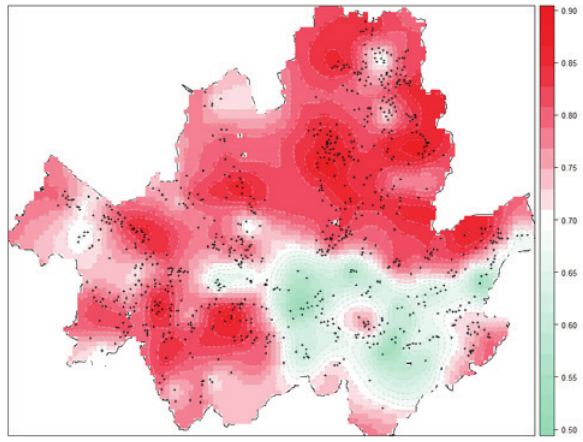
Figure 5. Spatial correlation of the rent-to-price ratio The symbol “+” indicates the location of the apartment complex, and the ratio is the average value between January and December of 2016. The ratio surface is created by a kriging method, a common technique for spatial